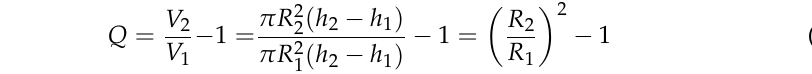
Figure 3. The model of uniform expansion of the grouting area. The rate of volume expansion of the soil ( Q ) before and after grouting can be de- fined as